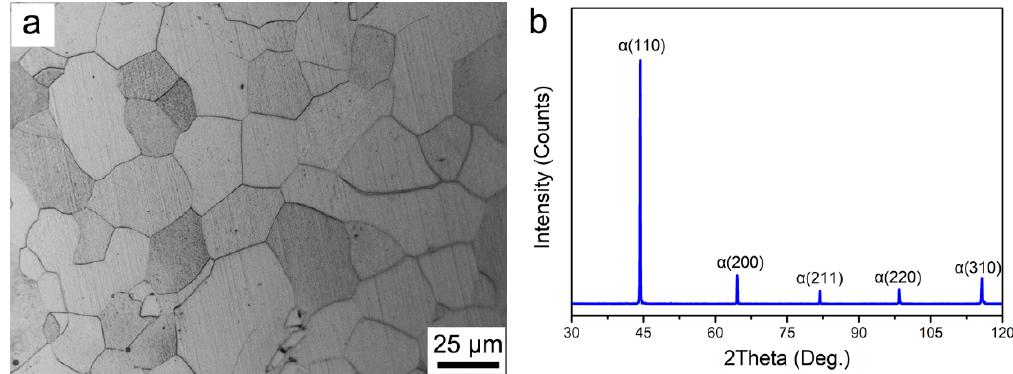
Figure 1. ( a ) Optical microstructure of the annealed 0Cr18AlSi steel and ( b ) corresponding X-ray diffraction